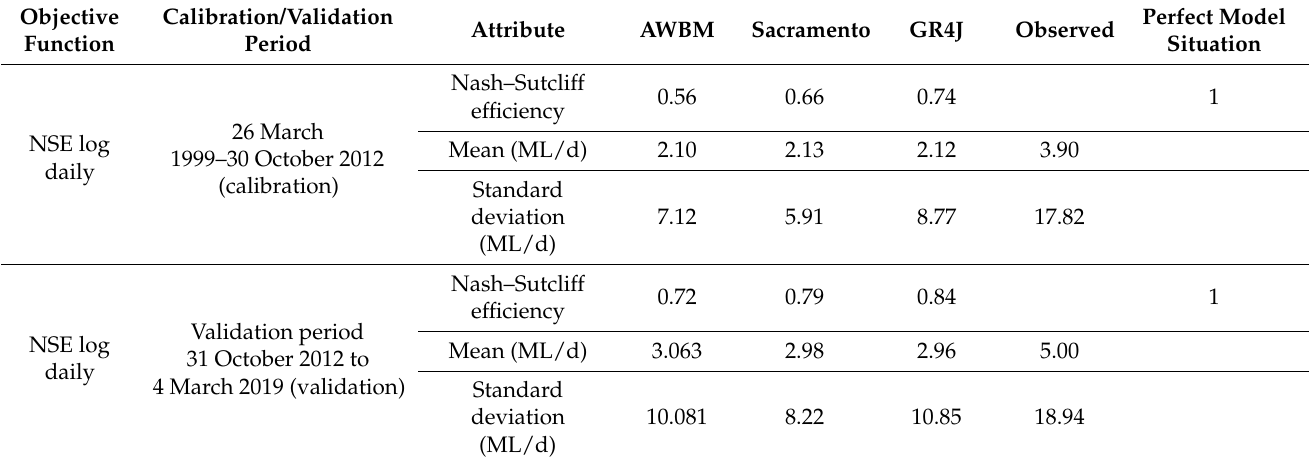
Table 4. Comparison of the three-model performance predicted by univariate